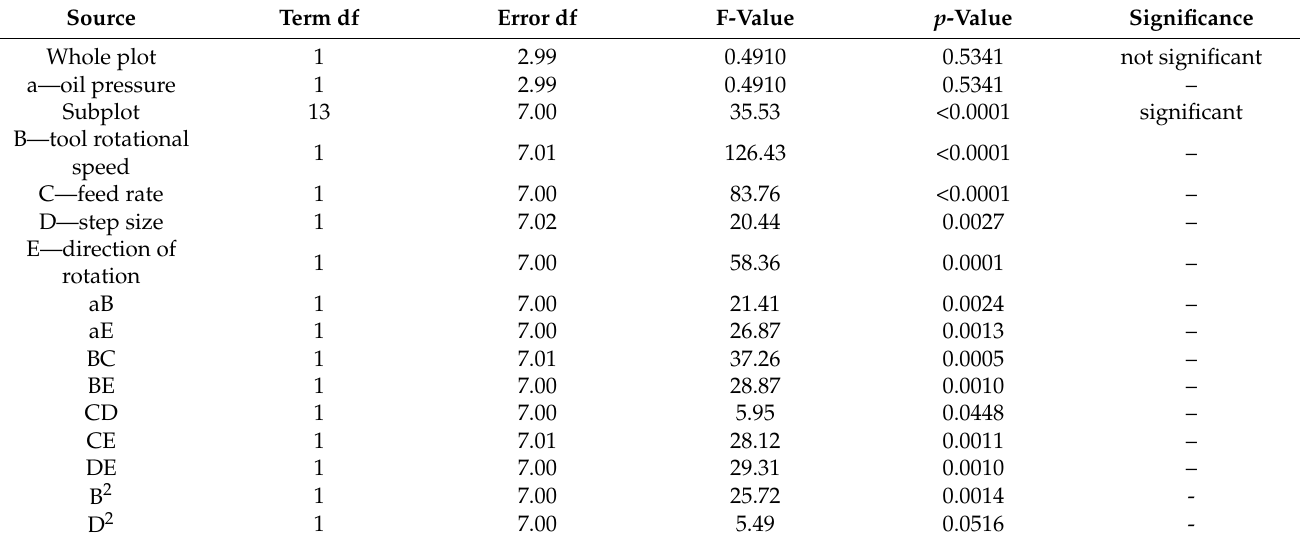
Table 5. REML analysis of the maximum formable wall angle.